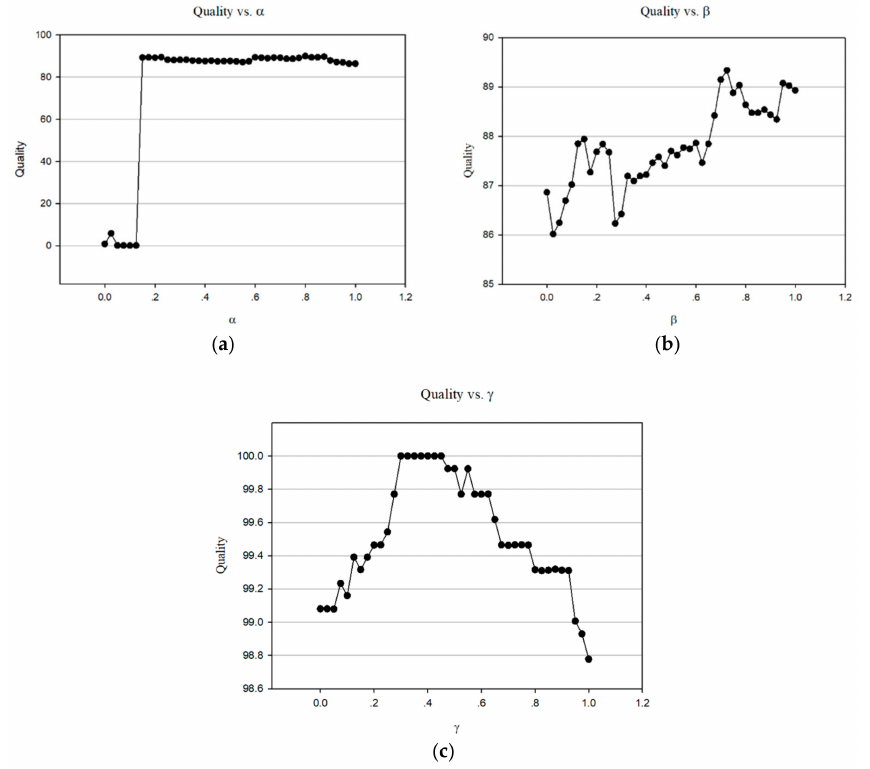
Figure 11. Quality of the results provided by the proposed method for the QuickBird image under different α , β , and λ values. ( a ) Quality vs. α ; ( b ) Quality vs. β ; ( c ) Quality vs. λ